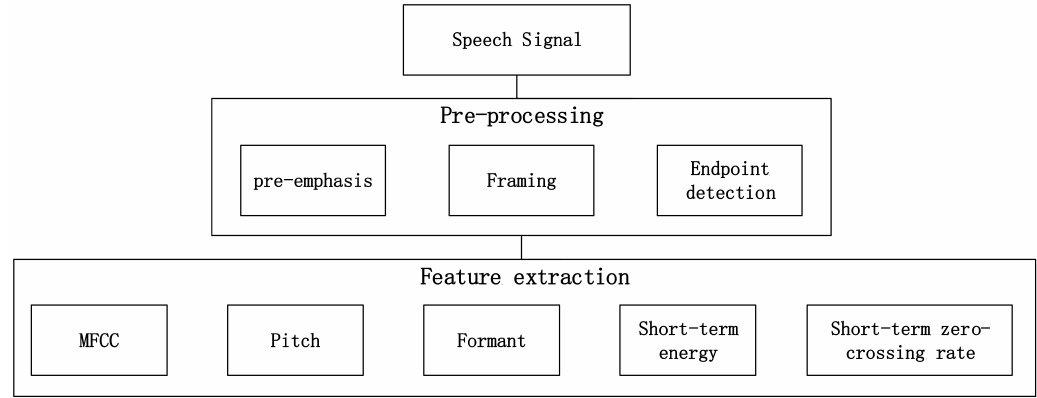
Figure 1. Process of extracting speech